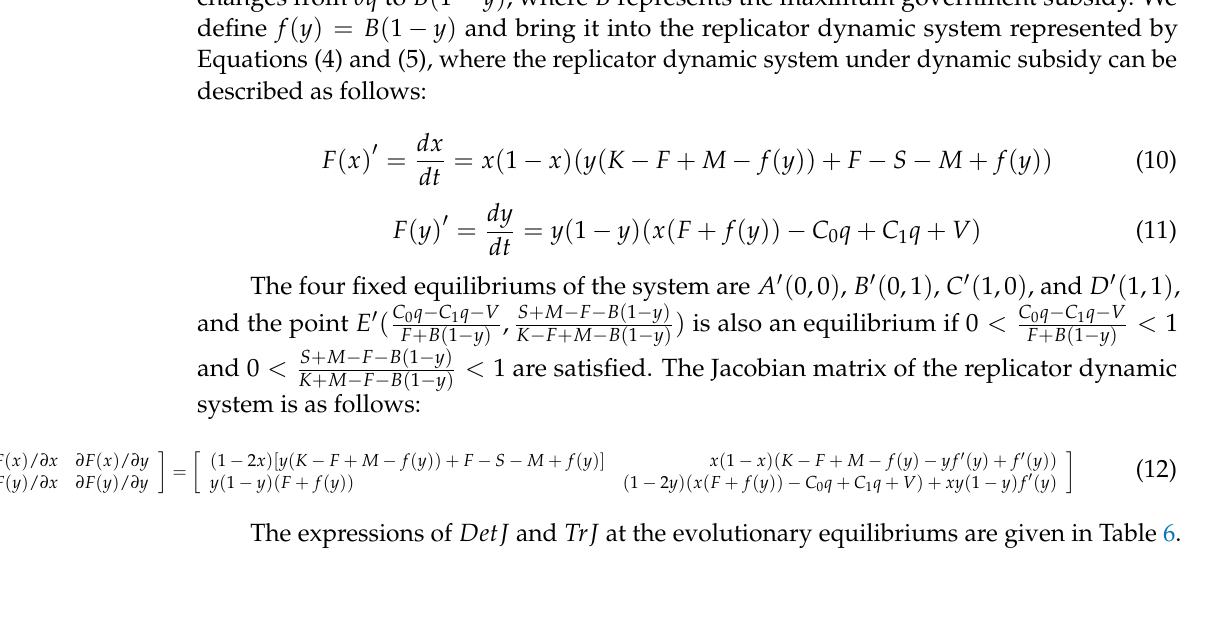
Table 6. Expressions of DetJ and TrJ at the evolutionary equilibriums under dynamic subsidy.